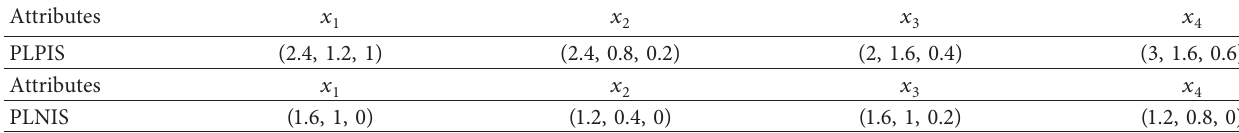
Table 28: The positive ideal solution and the negative ideal